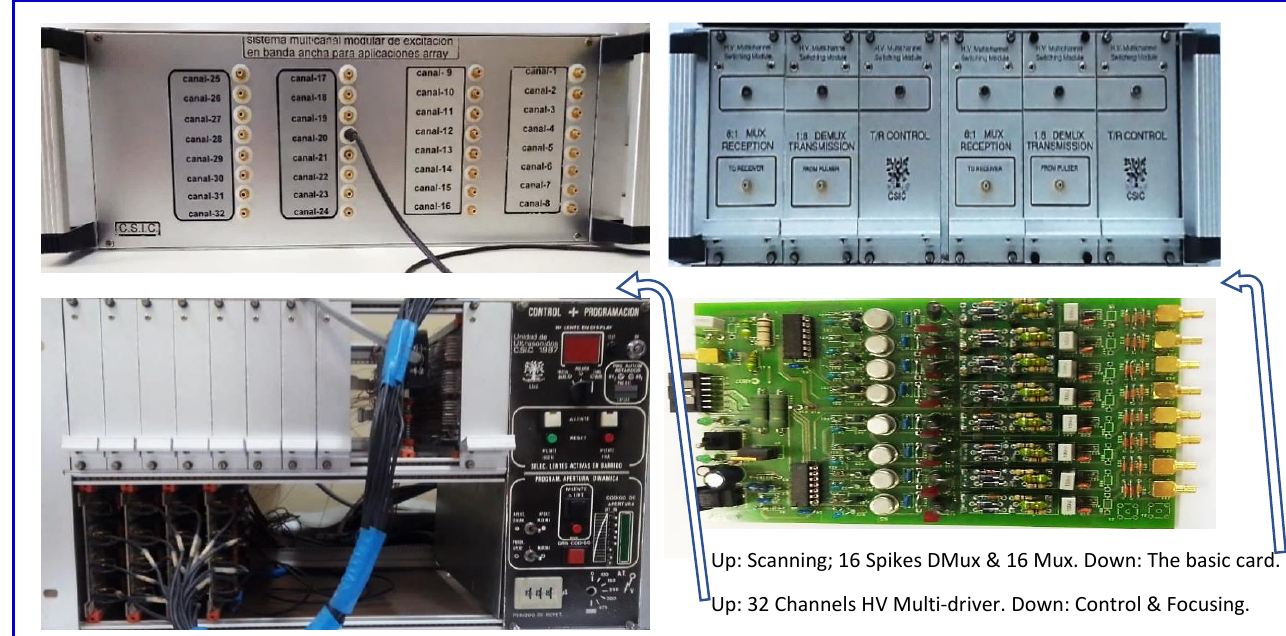
Figure 2. Lab equipment of own design for capacitive multi-driving, electronic focusing, and HV scanning [15] of PZT transducers.